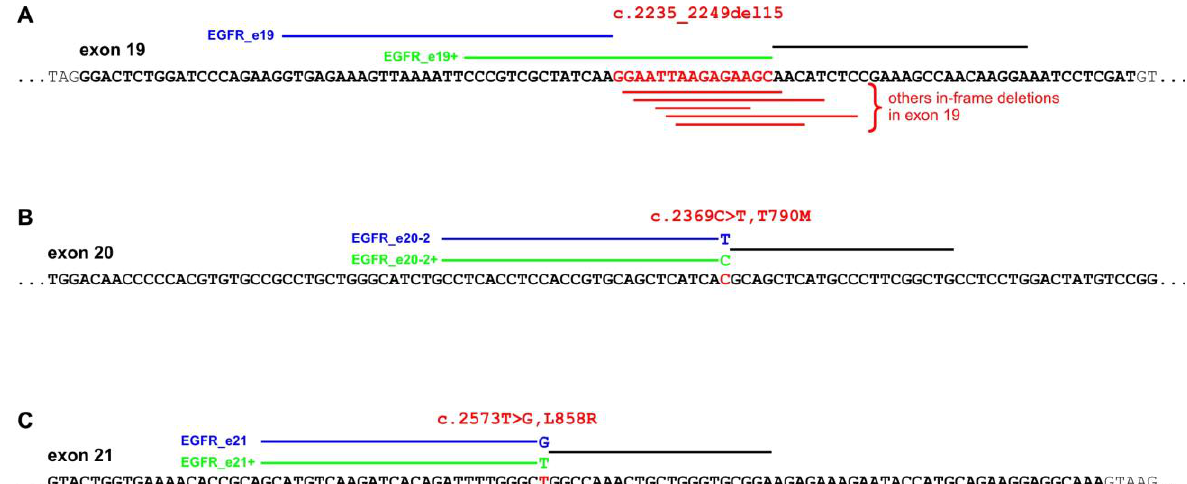
FIGURE 4. Pairs of target sequences for MS- and MS+ probes specific for (A) in-frame deletion c.2235_2249del15 in exon 19, (B) T790M in exon 20, and (C) L858R in exon 21. Black lines: 3’ TSS shared by the MS- and MS+ probes; green and blue lines: 5’ TSSs specific for the normal and mutant sequences,